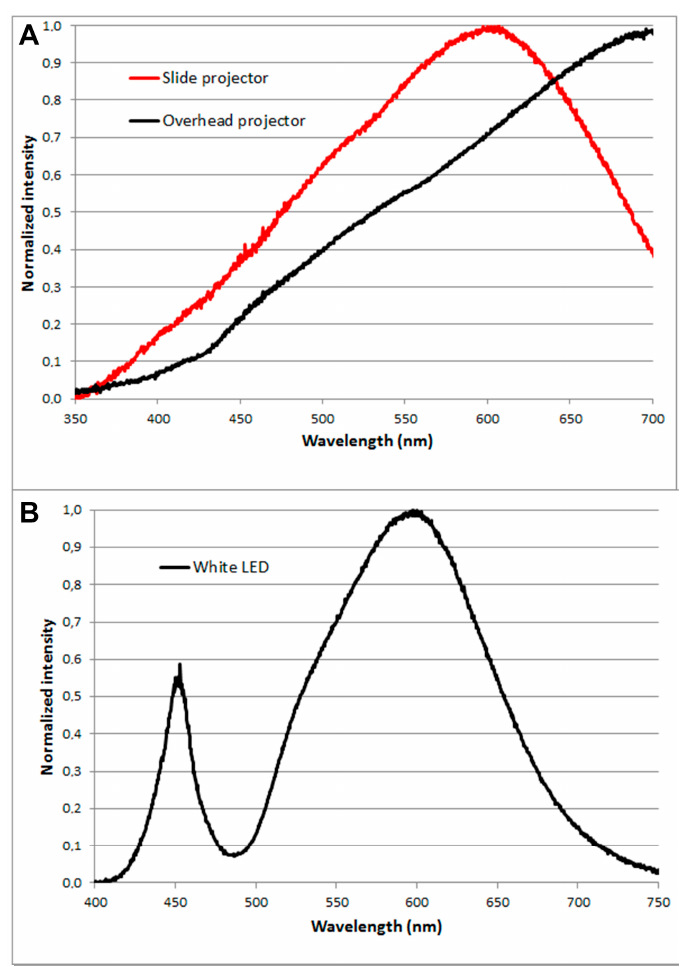
Figure 3. Cont. Figure 3.